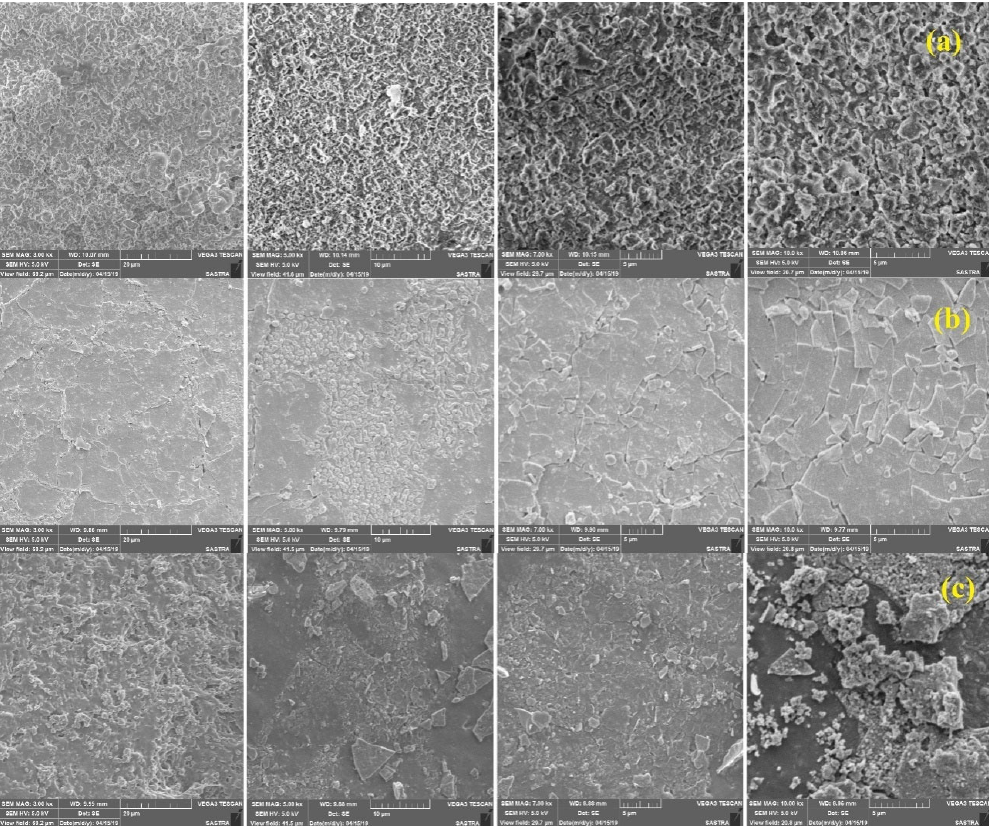
Figure 8. SEM micrographs of the eroded samples after the tracking with the magnification level of 3000, 5000, 7000, 10,000×: ( a ) Fresh, ( b ) thermal ‐ aged, ( c ) water ‐ aged. 3000, 5000, 7000, 10,000 × : ( a ) Fresh, ( b ) thermal-aged, ( c )